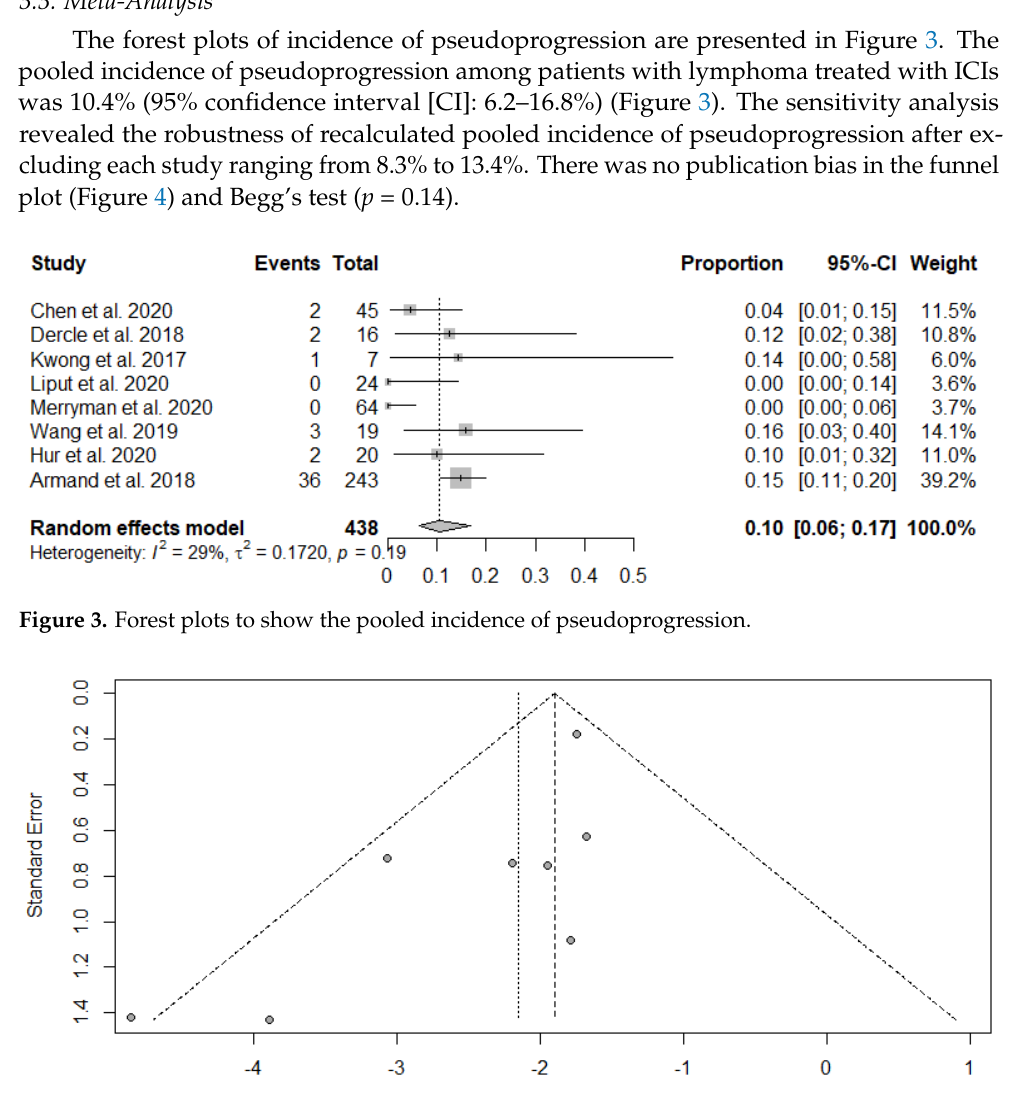
Figure 4. Funnel plots for visual appraisal of the literature bias.